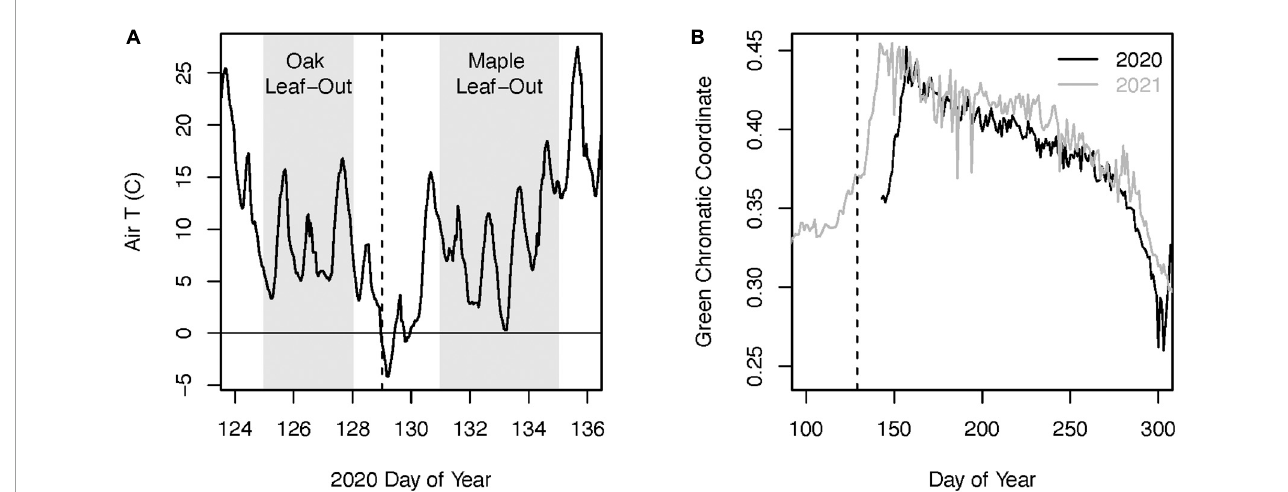
FIGURE2 Air temperature at Black Rock Forest during the leaf-out period of 2020 (A) . The gray shaded areas indicate the approximate time period of leaf bud break for the red oak and red maple trees in our plots. The green chromatic coordinate from phenocam data at Black Rock Forest (B) indicates the delayed leaf-out phenology following the defoliating freeze event in 2020 compared to the reference year of 2021. The dashed vertical lines in both figures indicate the night of the freeze event.